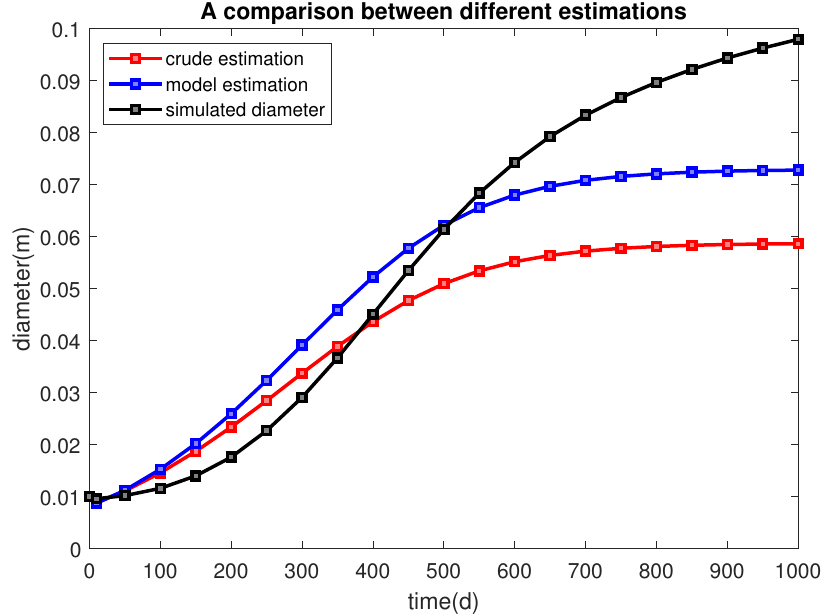
Figure 4. The diameter of the tumor is estimated from different sources. The red line, blue line, and black line represent the estimation from taking a square root, a linear model, and applying the displacement vector. It can be seen that the estimate obtained from applying the displacement vector is